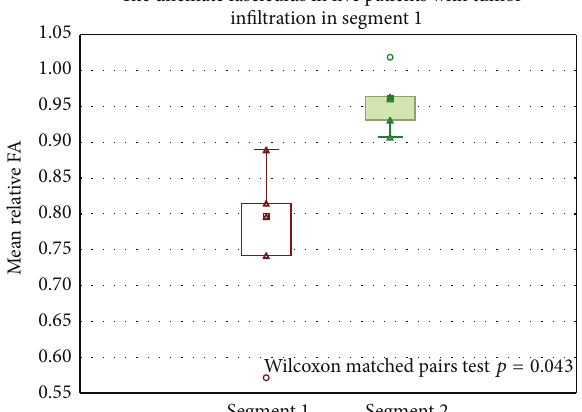
Figure 4: Box plot of rFA in tract segments. rFA in segments 1 and 2 in the uncinate fasciculus, in five patients with tumor infiltration in segment1.SignificantlylowerrFAinsegment1comparedtosegment 2. Wilcoxon matched pairs test, 𝑝 = 0.043 . rFA = relative fractional